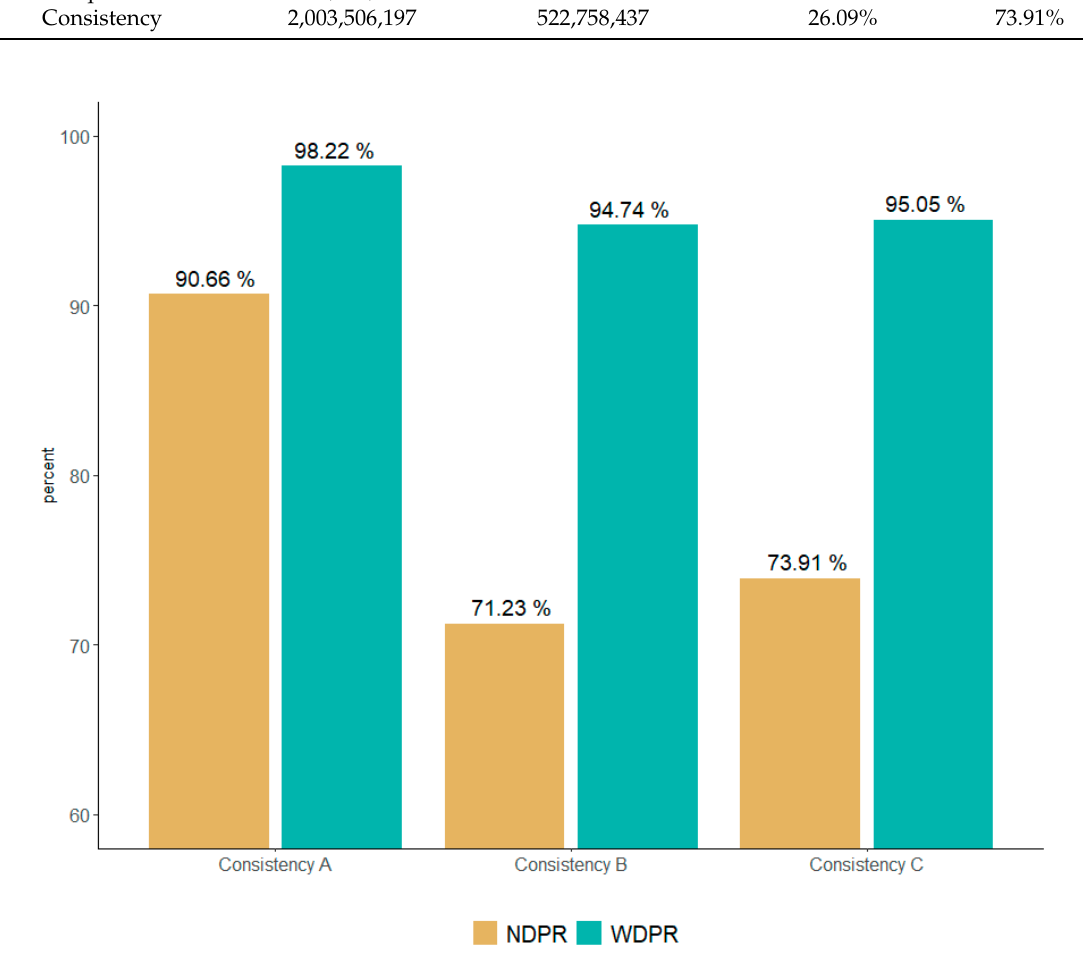
Figure 2. Comparison of NDPR and WDPR by consistency weights. Table 5. Multicenter OMOP CDM data quality assessment specific results.